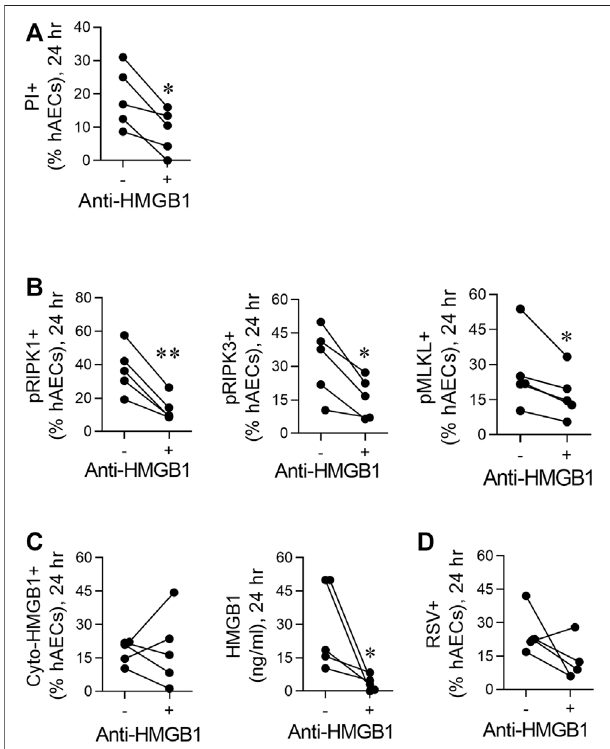
FIGURE 3 | RSV induces necroptosis in hAECs in an HMGB1- dependent manner. hAECs were pre-treated with a neutralising HMGB1 antibody then inoculated with RSV (MOI of 1). Endpoints were assessed at 24 hpi. (A) Quanti fi cation of PI positive hAECs. (B) Quanti fi cation of pRIP1K, pRIPK3 and pMLKL positive hAECs. (C) Quanti fi cation of cytoplasmic HMGB1 and HMGB1 levels in the cell culture supernatant. (D) Quanti fi cation of RSV positive hAECs. Data are presented as dot plots with each datapointrepresentingoneof5donors. Thedatawereanalyzed usinga